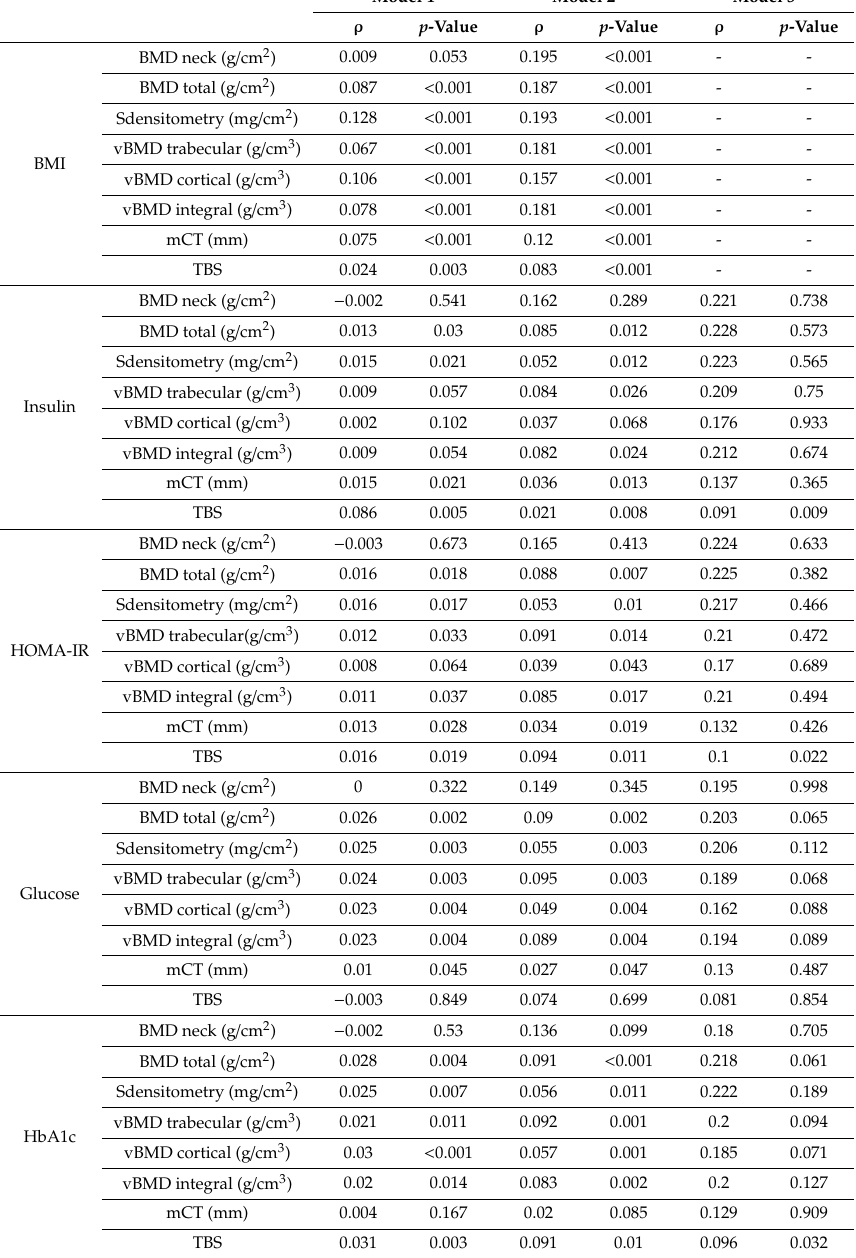
Table 4. Lineal regression analysis between the di ff erent parameters (BMI, insulin, HOMA-IR, glucose, and HBA1c) and the densitometry parameters. In Model 1, the linear regression analyses were adjusted by past and present medication, lifestyle factors, and the presence of osteoporosis and osteoporosis risk factors. In Model 2, they were adjusted by past and present medication, lifestyle factors, age, and the presence of osteoporosis and osteoporosis risk factors. Lastly, in Model 3, they were adjusted by past and present medication, lifestyle factors, age, BMI, and the presence of osteoporosis and osteoporosis risk